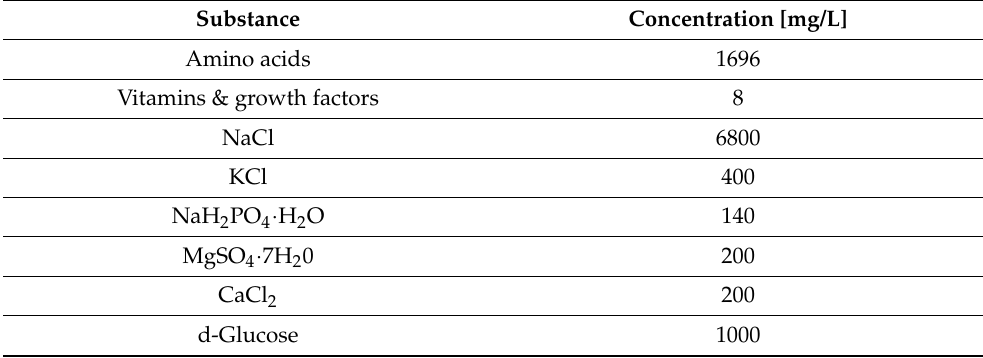
Table 1. Electrolyte composition